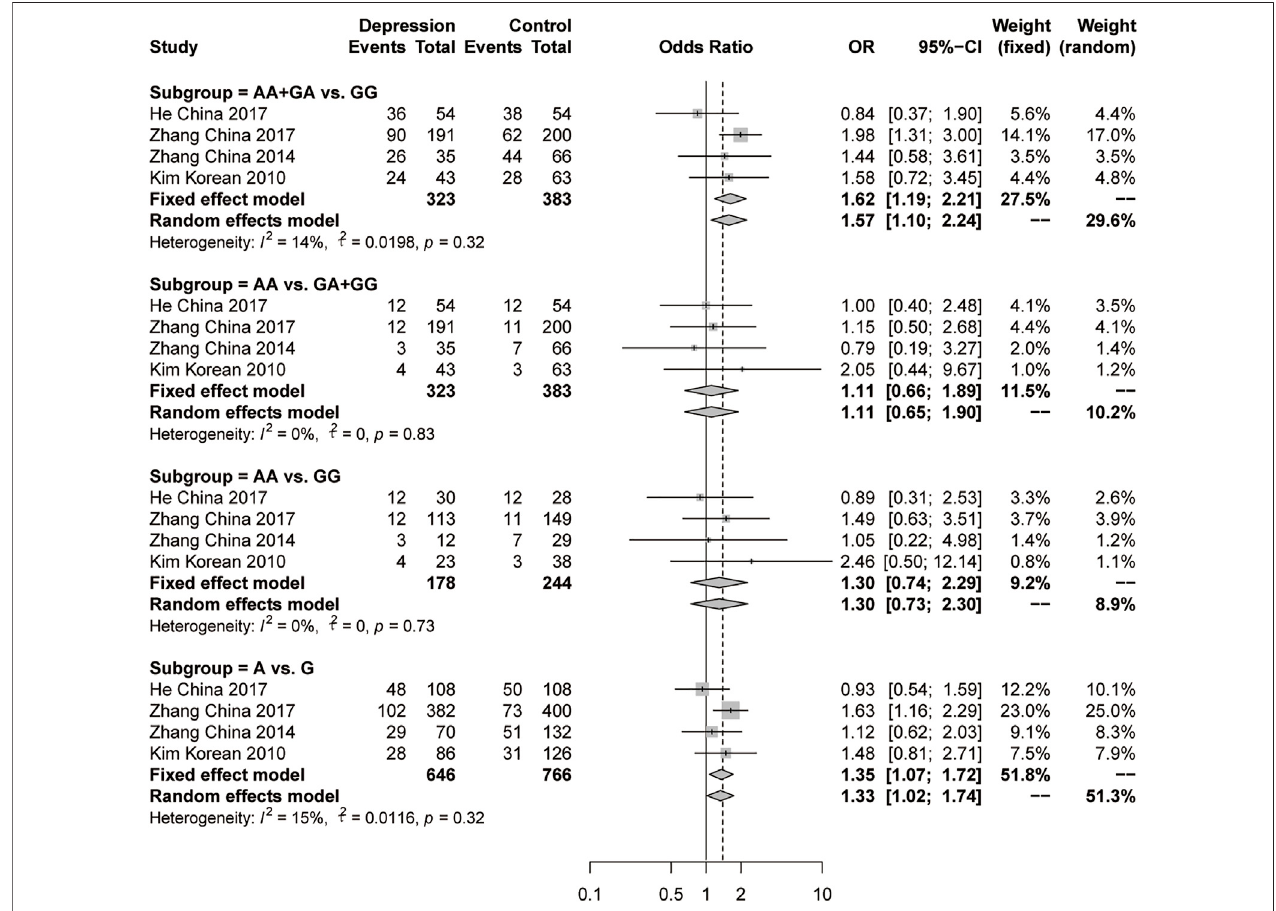
FIGURE 5 | Forest plot of studies comparing the distribution of the rs1256049 polymorphism of ER β between women with depression and controls after the omission of Kang ’ s study.